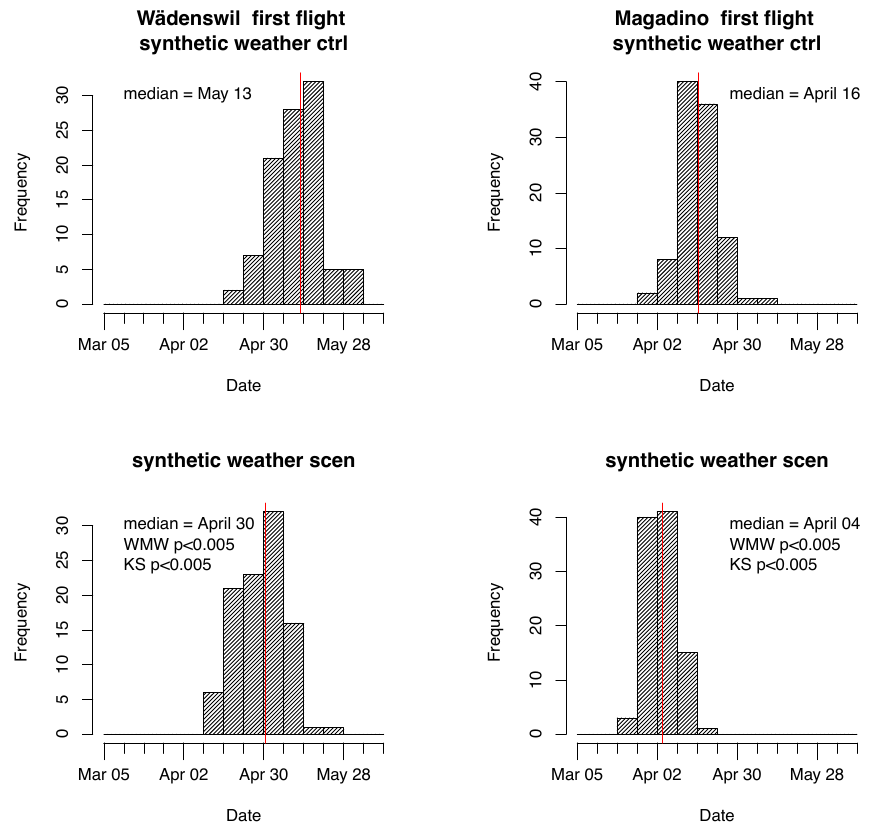
Fig. 4. As Fig. 3 (top row), but for the flight start in spring from synthetic weather for present (“ctrl”, top panel) and future (“scen”, bottom panel) climate at the stations W¨adenswil (left panels) and Magadino (right panels). In the bottom panels, the p-values for the Wilcoxon- Mann-Whitney (WMW) and the Kolmogorov-Smirnov (KS) tests are displayed for the difference between flight start from present-day and future synthetic